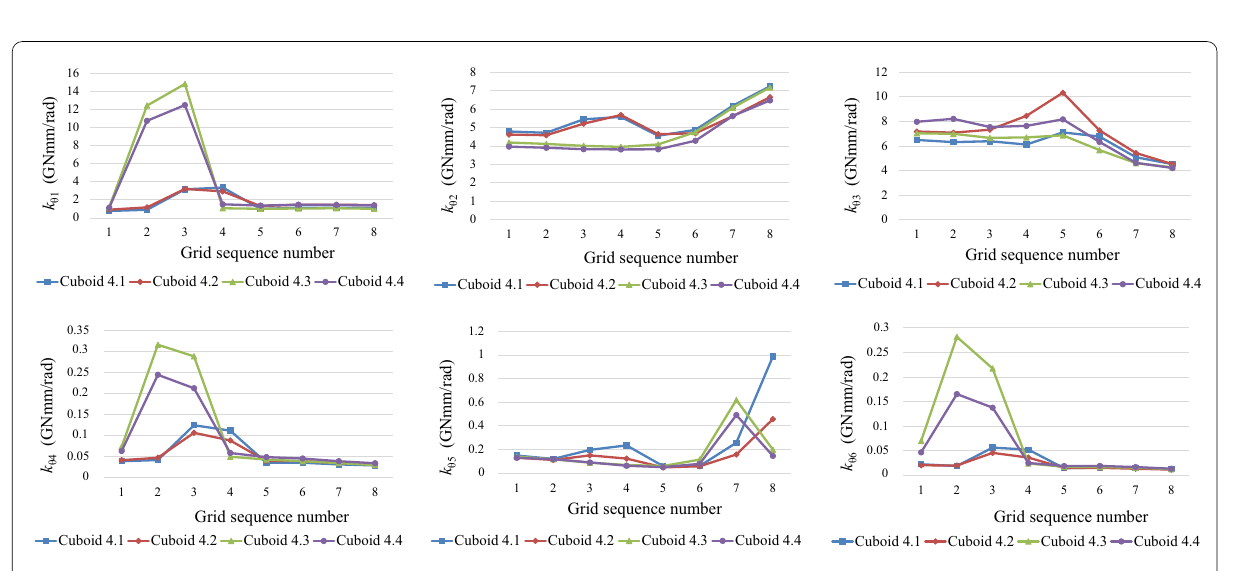
Figure 15 Joint stiffness in Cuboid